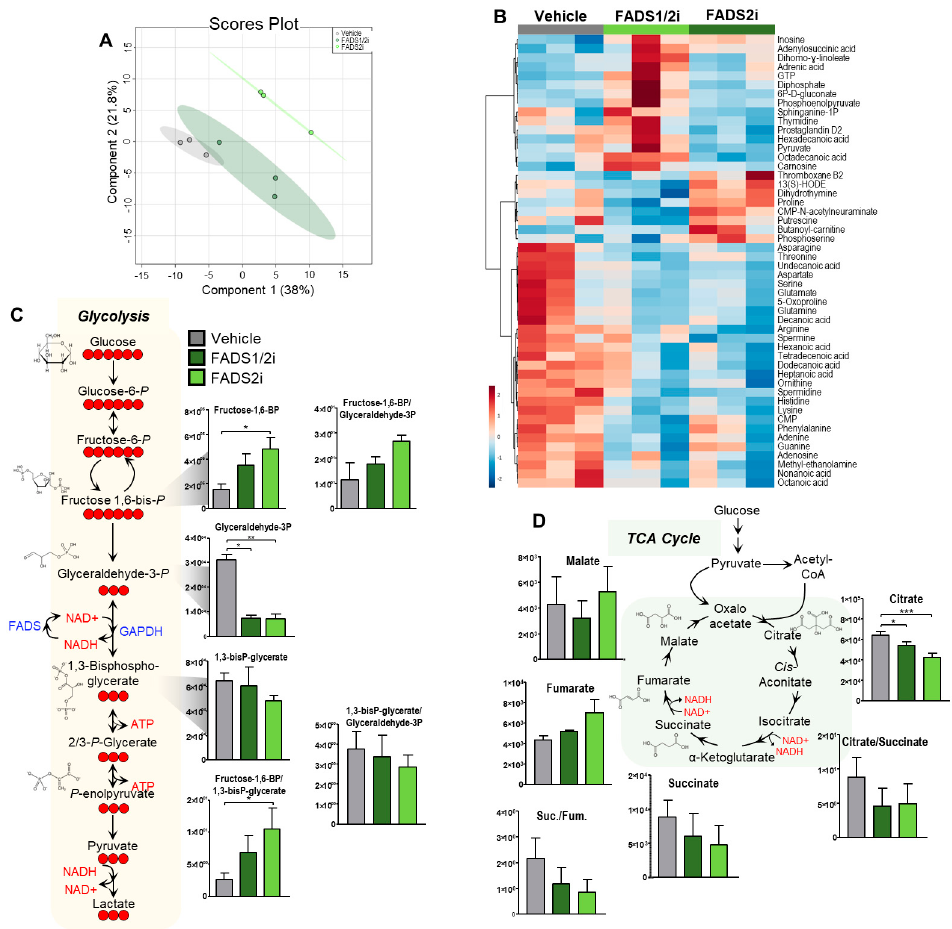
Figure 7. Inhibition of FADS1 and FADS2 leads to alterations in glycolytic metabolism. ( A ) PLSDA comparing bulk AML cells from relapsed patients treated with vehicle, 5 µ M CP24,879 (FADS1/2i), or 0.5 µ M SC26196 (FADS2i). ( B ) Global heatmap showing the top 50 most significant metabolites by ANOVA, comparing bulk AML cells from relapsed patients treated with vehicle, 5 µ M CP24,879 (FADS1/2i), and 0.5 μ M SC26196 (FADS2i). ( C ) Levels of U13C glycolytic intermediates after 4 h of incubation with U13C heavy stable isotope labeled glucose in relapsed LSCs with vehicle, 5 μ M CP24,879 (FADS1/2i), or 0.5 μ M SC26196 (FADS2i). ( D ) Levels of 13C TCA cycle intermediates after 4 h of incubation with U13C heavy stable isotope labeled glucose in relapsed LSCs with vehicle, 5 μ M CP24,879 (FADS1/2i), or 0.5 μ M SC26196 (FADS2i). * p ≤ 0.05, ** p ≤ 0.01, *** p ≤ 0.001.